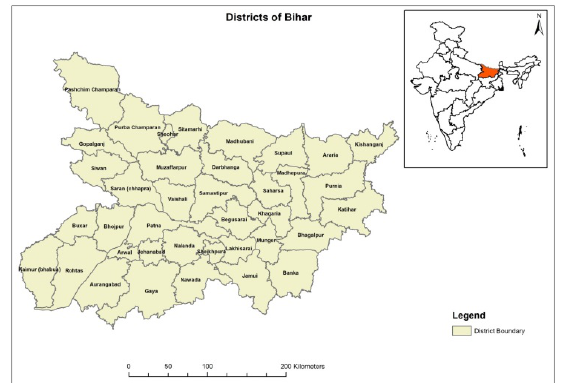
Table 1. Data used and their